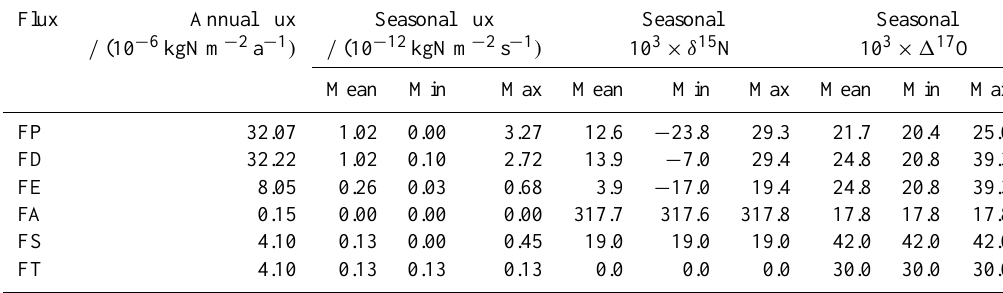
Table 6. Simulated nitrate mass fluxes and their isotopic composition in the case of the DC realistic simulation.